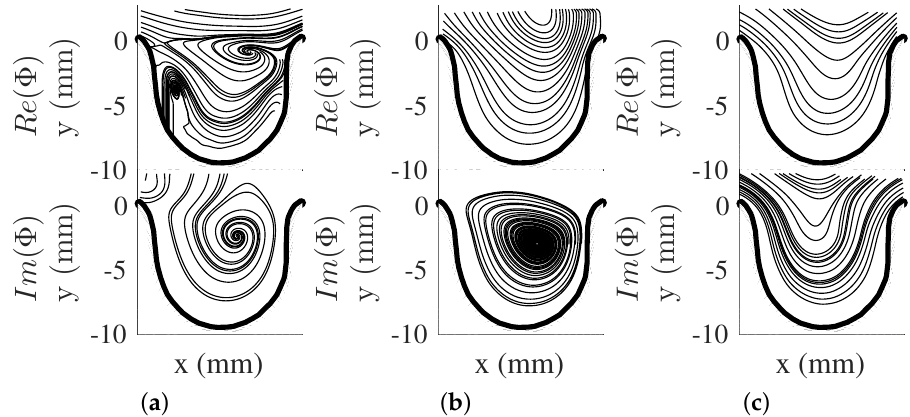
Figure 6. DMD modes for Re p = 150. ( a ) 0.4 Hz mode, ( b ) 0.8 Hz mode, ( c ) 1.6 Hz